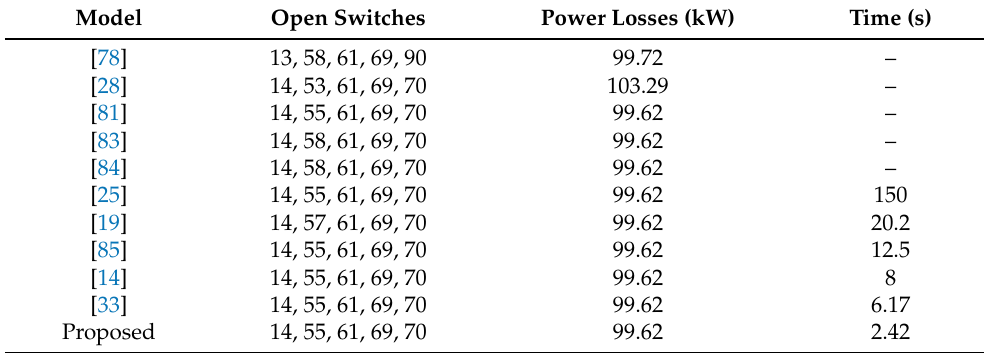
Table 13. Comparative analysis of the 69-bus test system.